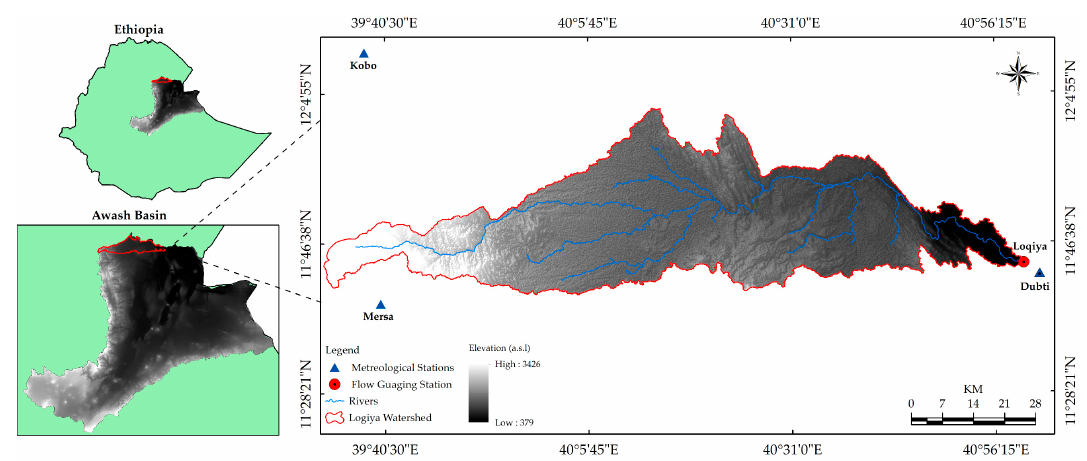
Figure 1. Location of the Logiya watershed, meteorological and flow gauging stations.